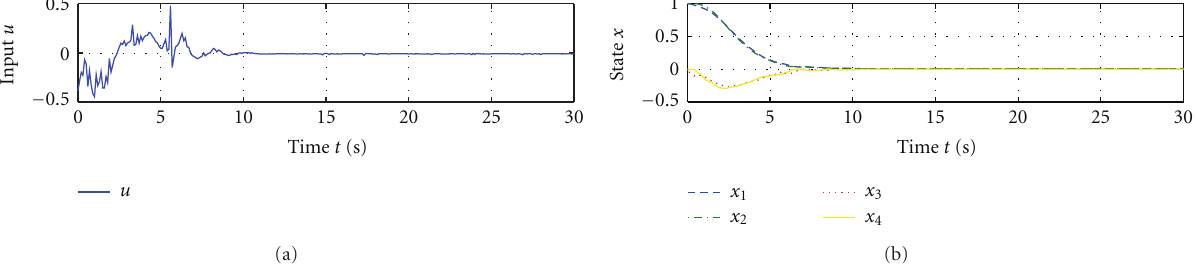
Figure 4: Closed-loop response of the coupled spring-mass system with γ 2 = 0 . 45.